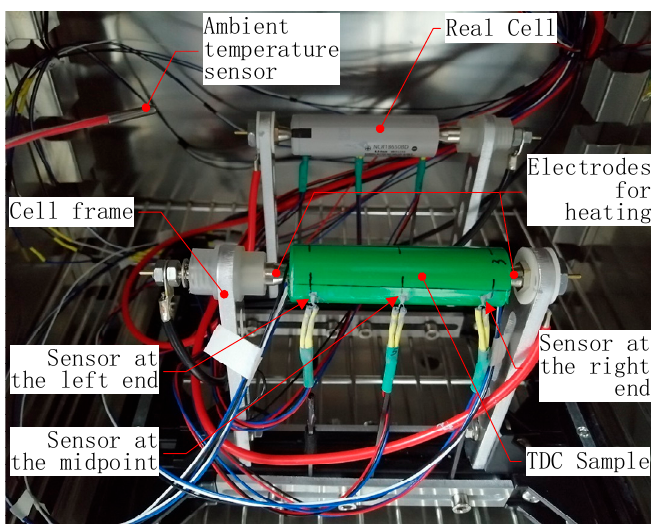
Figure 5. Experimental setup.